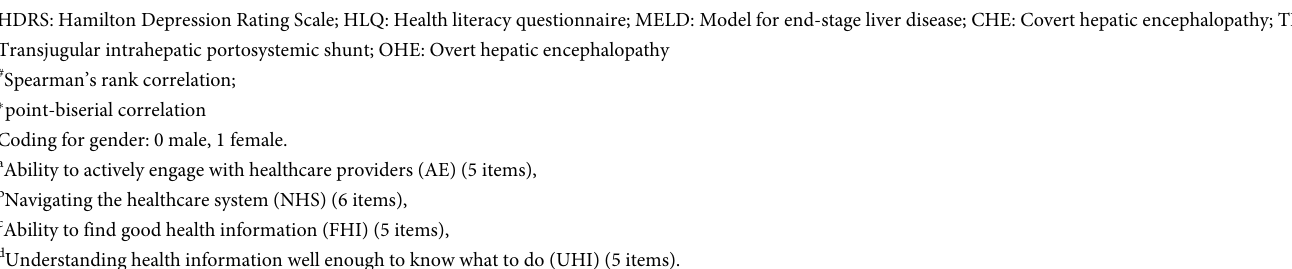
Spearman’s rank correlation; � point-biserial correlation Coding for gender: 0 male, 1 female. a Ability to actively engage with healthcare providers (AE) (5 items), b Navigating the healthcare system (NHS) (6 items),